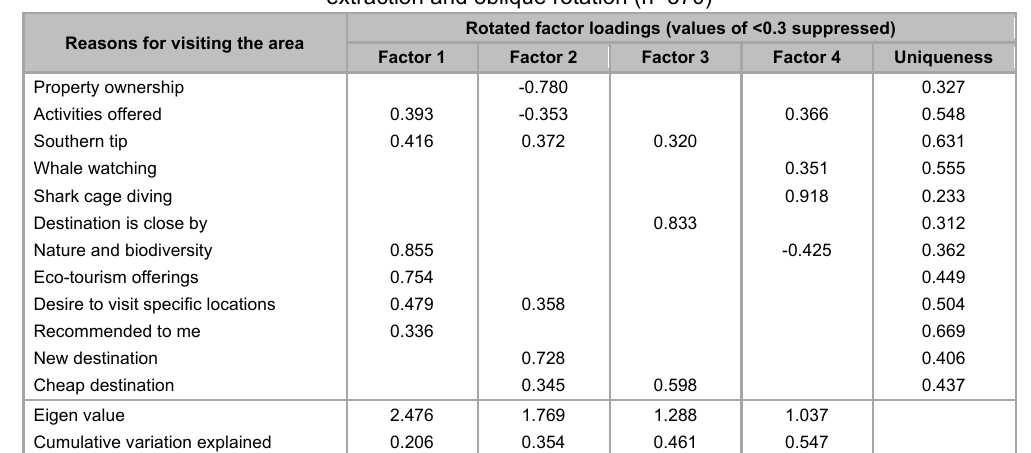
Factor analysis of the Agulhas Plain’s main attractions using principle component extraction and oblique rotation